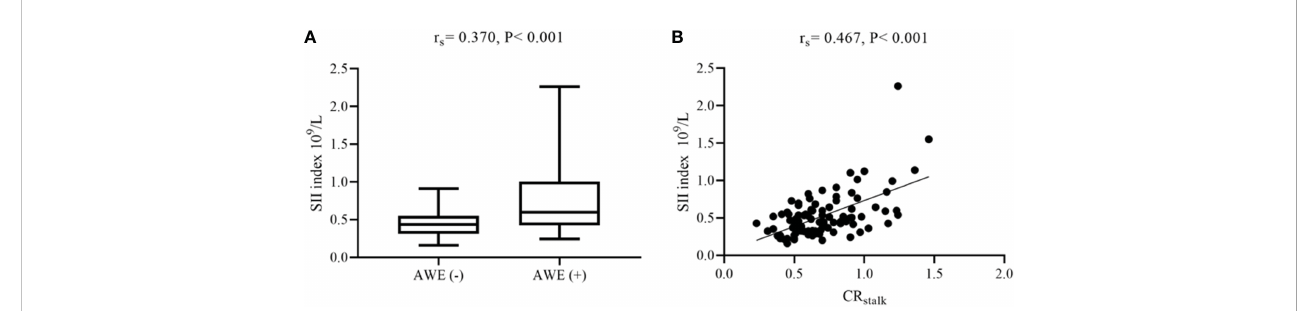
FIGURE 3 Associations between AWE, CR stalk , and the SII index. (A) Box plot comparing the SII index for AWE and non-AWE aneurysms. (B) Scatter plot of the SII index and CR